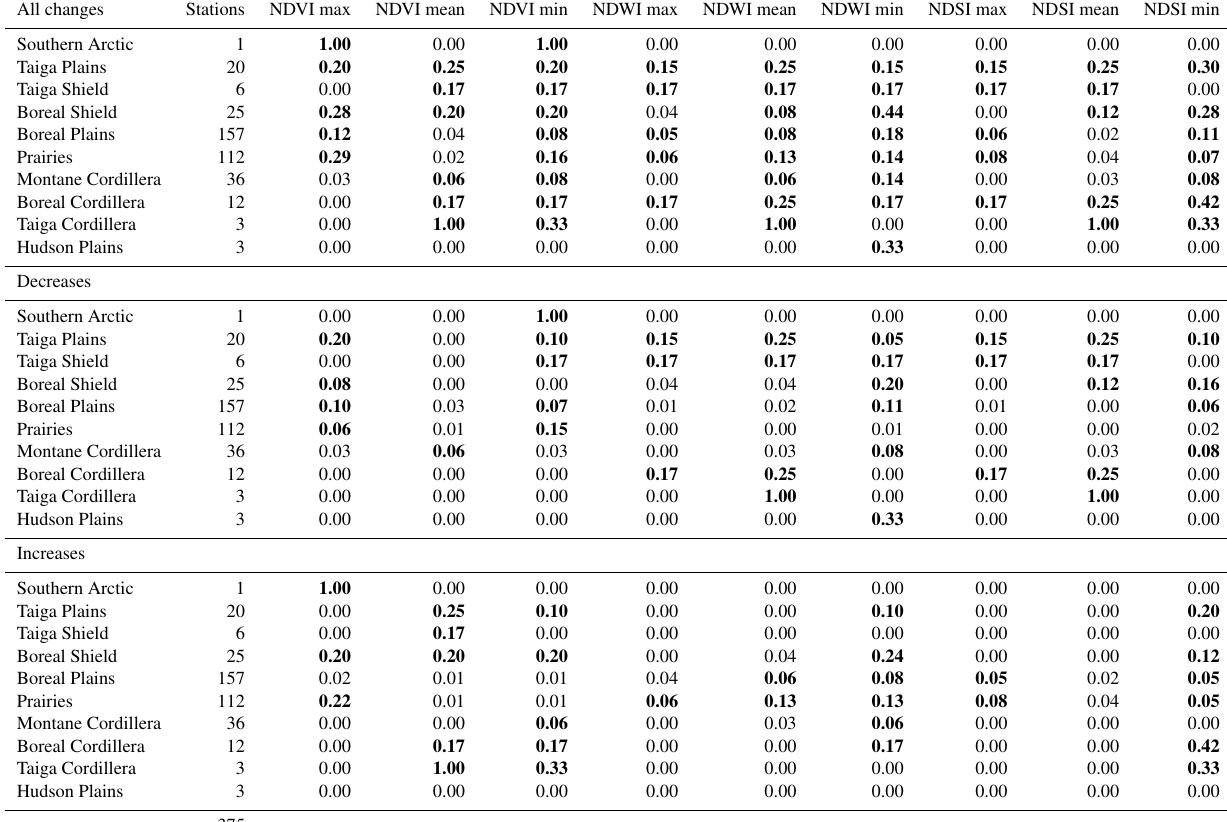
Table 9. Changes in satellite indices in relation to ecozones. The numbers are the fraction of stations showing a trend; values greater than 0.05 are in